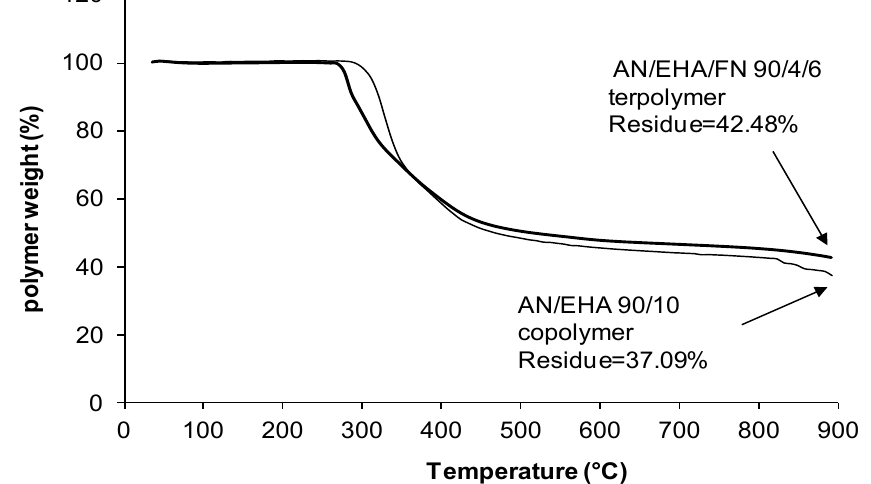
Figure 8. TGA thermograms of AN/EHA 90/10 copolymer and AN/EHA/FN 90/4/6